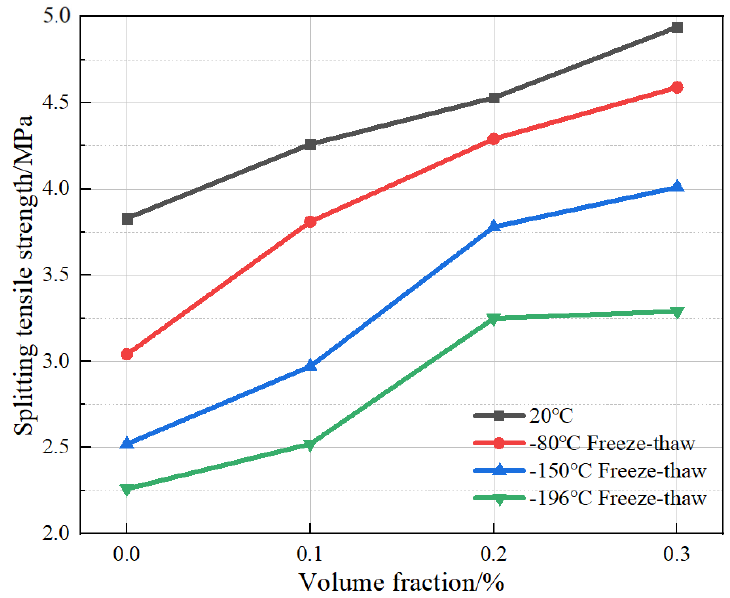
Figure 16. Effect of fiber volume on the splitting tensile strength of BFRC.